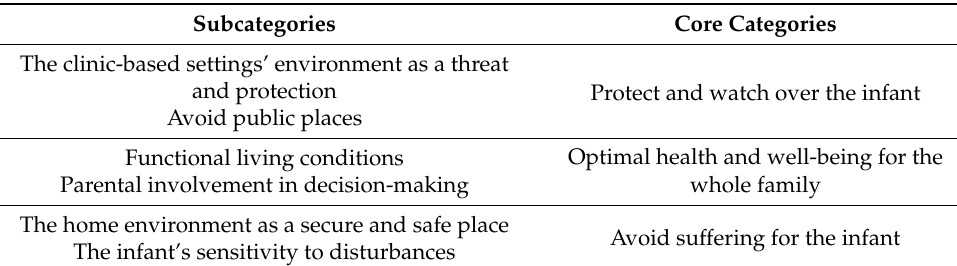
Table 2. Subcategories and core